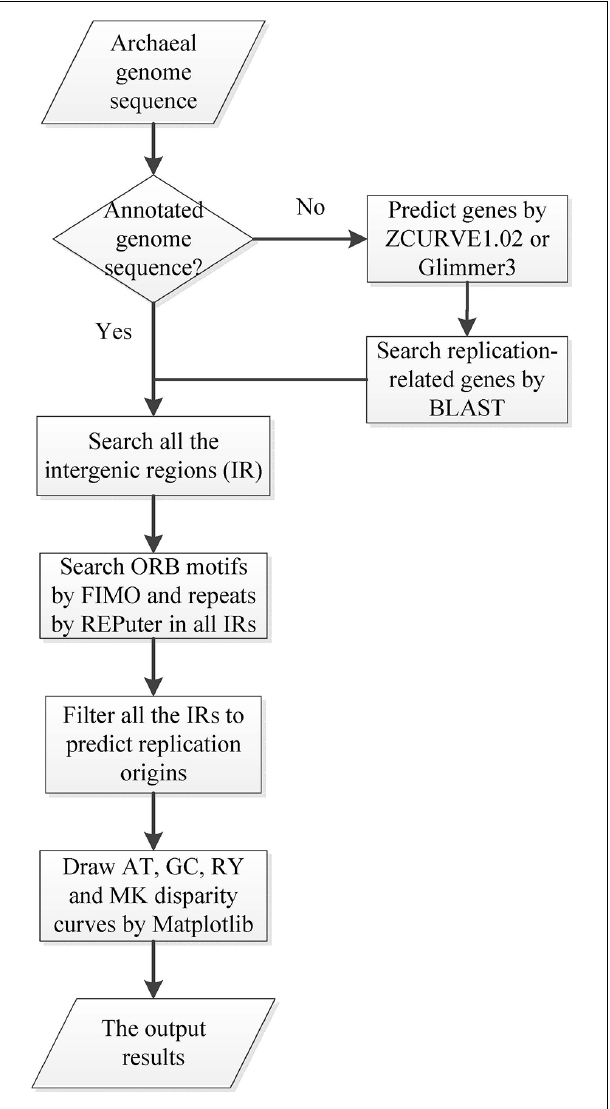
FIGURE 1 |Workflow diagram of Ori-Finder 2. The flow chart schematically shows the procedure to identify oriC regions by Ori-Finder